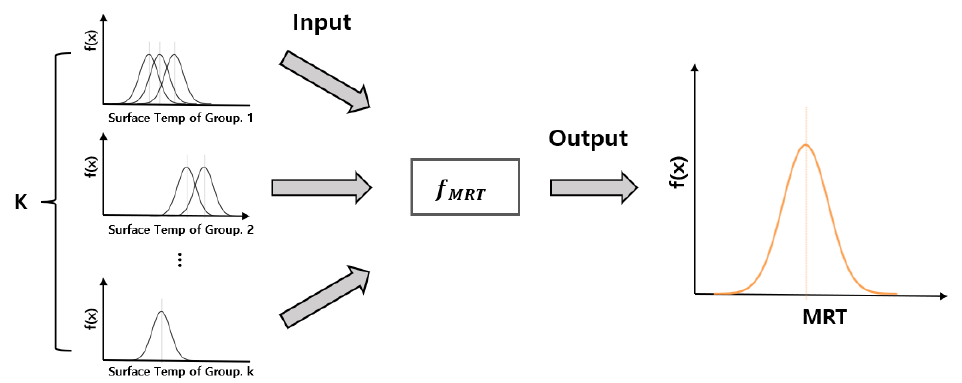
Figure 9. Schematic view of Monte Carlo simulation to estimate the uncertainty of MRT.